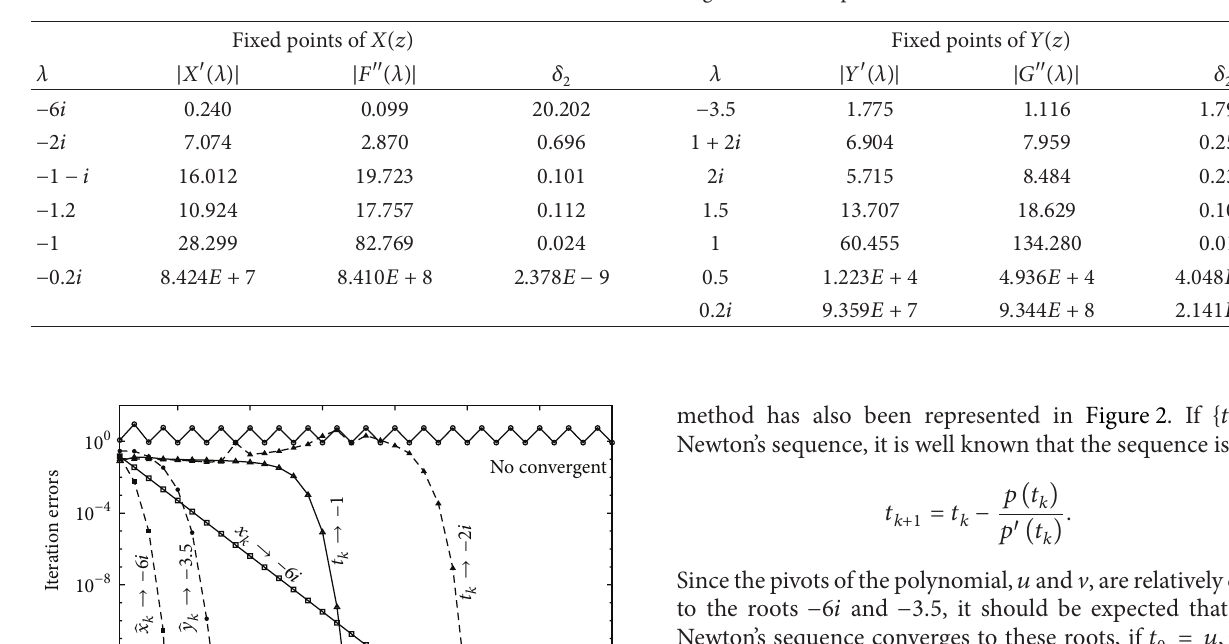
Table 1: Results of local convergence for Example 1.